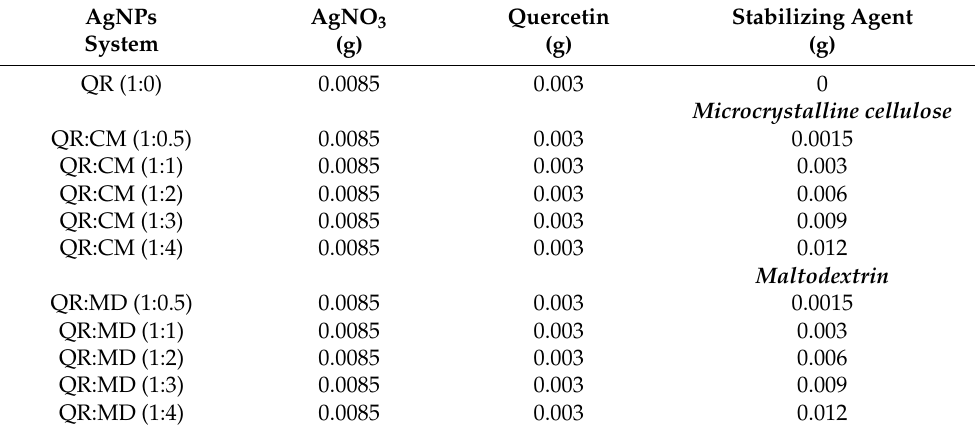
Table 1. Preparation of AgNPs at different ratios of stabilizing